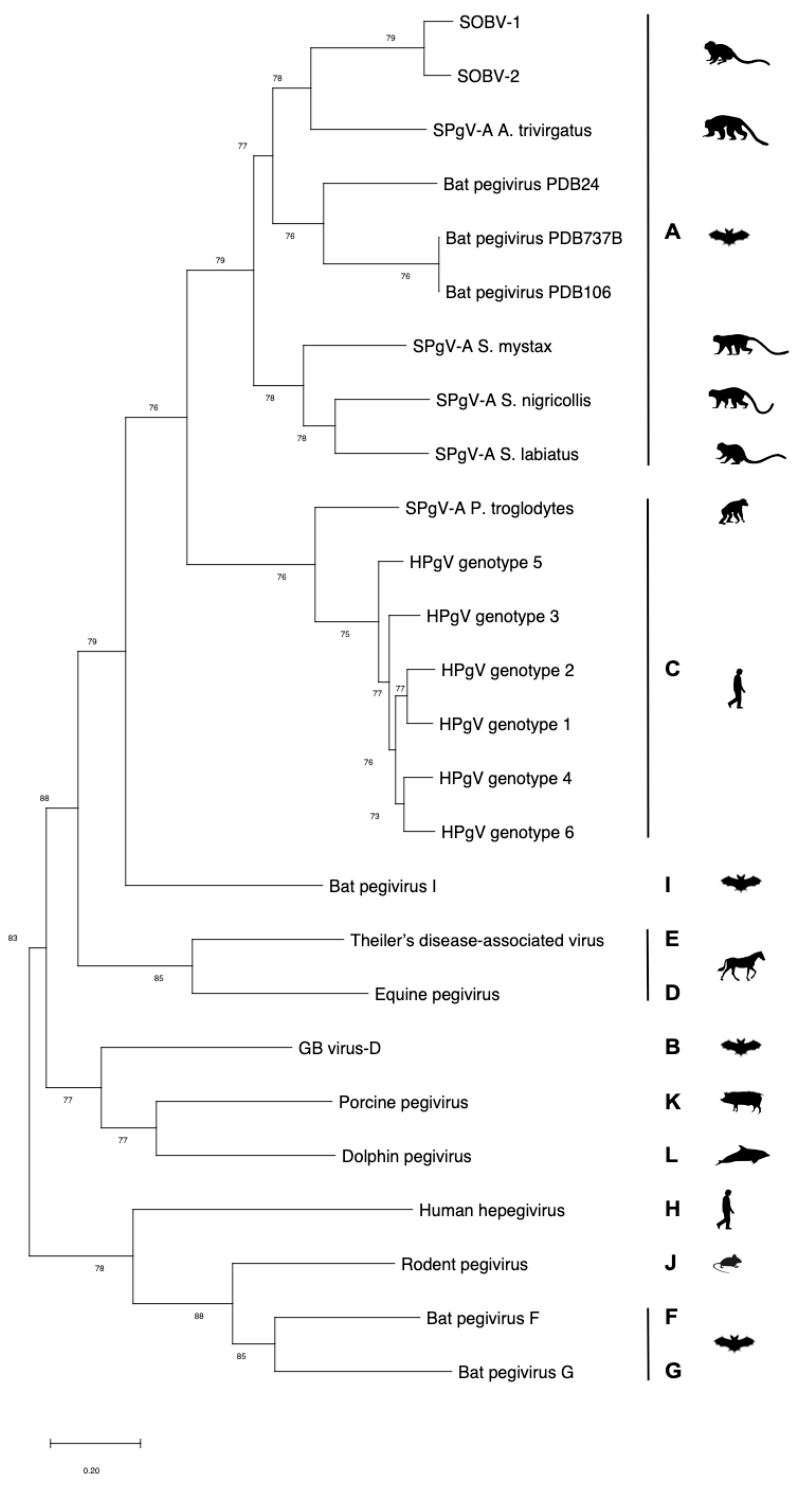
Figure 1. A phylogenetic tree of newly discovered pegivirus Southwest bike trail virus (SOBV) variants 1 and 2 shows it is most closely related to pegiviruses found in other New World monkeys and bats. We generated maximum likelihood trees using MEGA6.06 (1000 bootstrap replicates, GTR + I + γ model) from codon-based alignments (via MAFFT); bootstrap values of less than 70 were omitted. Abbreviations : HPgV = human pegivirus; SPgV = simian pegivirus.